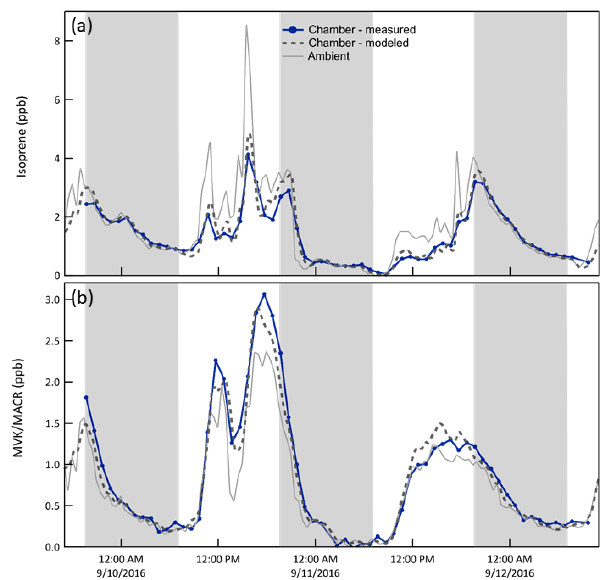
Figure 8. Mixing ratio time series of isoprene and its reaction prod- ucts methyl vinyl ketone (MVK) + methacrolein (MACR) (i) mea- sured and (ii) expected in Chamber B, and (iii) measured outside. Isoprene that enters through the ePTFE membrane reacts with OH (cid:113) O 3 , and NO 3 in the chamber, resulting in a lower mixing ratio than outside. The shaded bands represent nighttime.